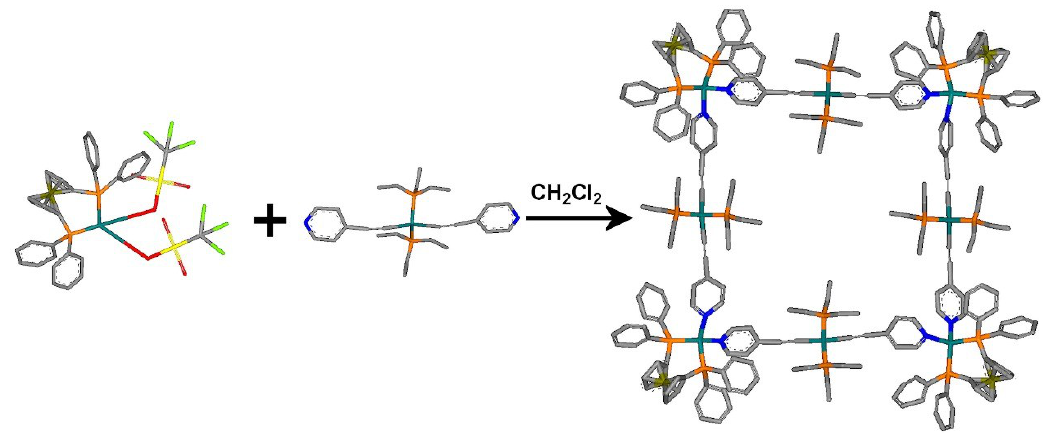
Figure 23. Heterometallic self-assembled square-shaped molecular sensor. (Colour scheme: Pd/Pt, teal; Fe, dark yellow; C, grey; N, blue; O, red; S, yellow; P, orange; F, bright green). Adapted from Chem. Rev. 2012 , 41 , 3046–3052. Copyright (2011) Royal Society of Chemistry.